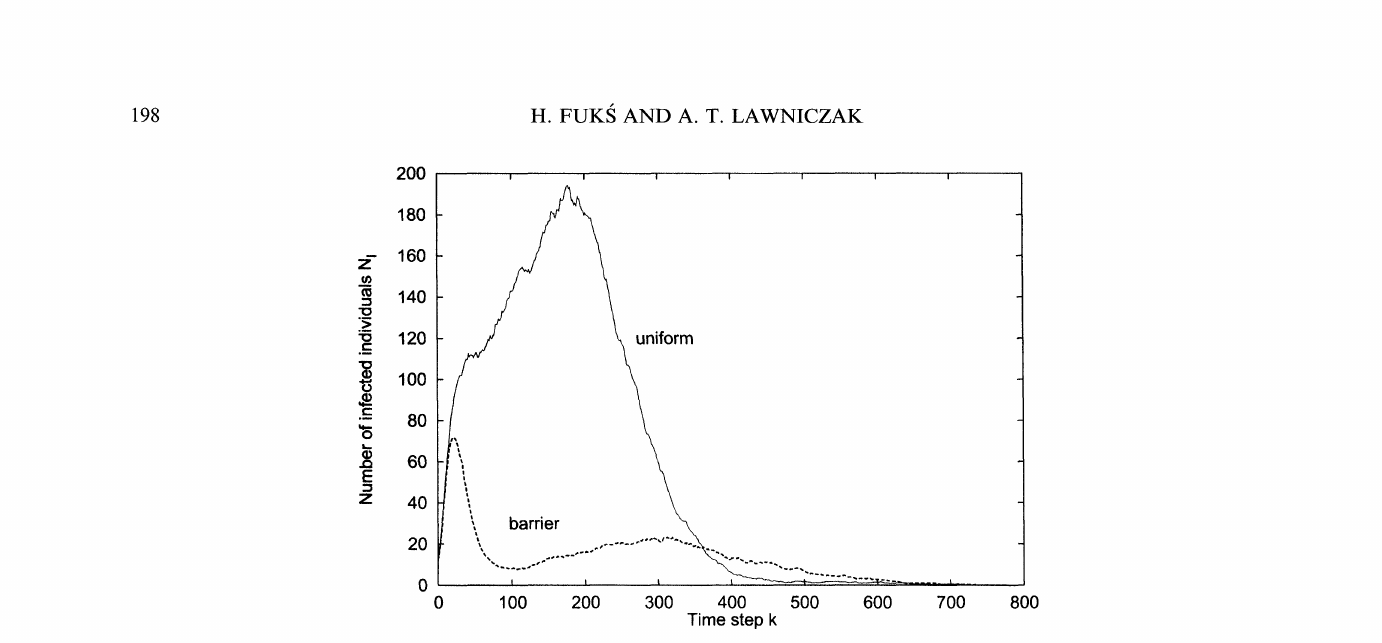
FIGURE 4 Number of infected individuals as a function of time, under "uniform" and "barrier" vaccination strategies. Each simulation curve represents average of 100 LGCA experiments. For each type of vaccination strategy each simulation has been performed on a hexagonal lattice with 104 nodes with r=0.3, a=0.2, and with 16000 susceptibles uniformly and randomly distributed on the lattice at k 0, and 10 infectives uniformly and randomly distributed in the circle of radius 20 on the lattice at